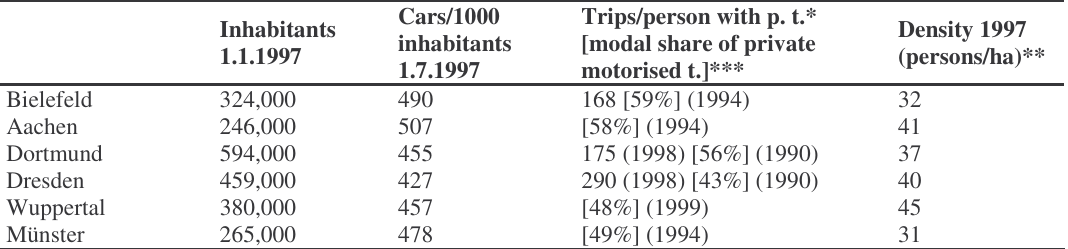
Table 2. Key factors for urban transport in five German